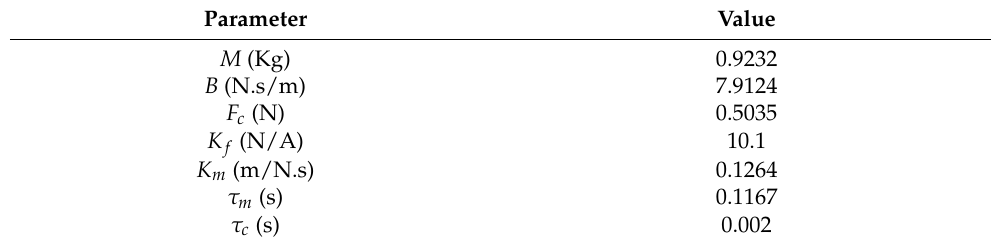
Table 3. Nominal parameters of the voice-coil motor.